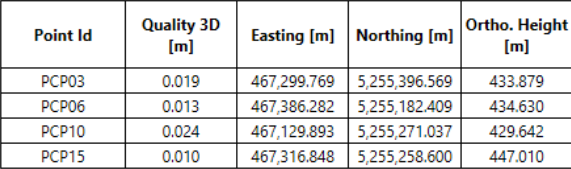
Table 2 . CPs coordinates and quality.